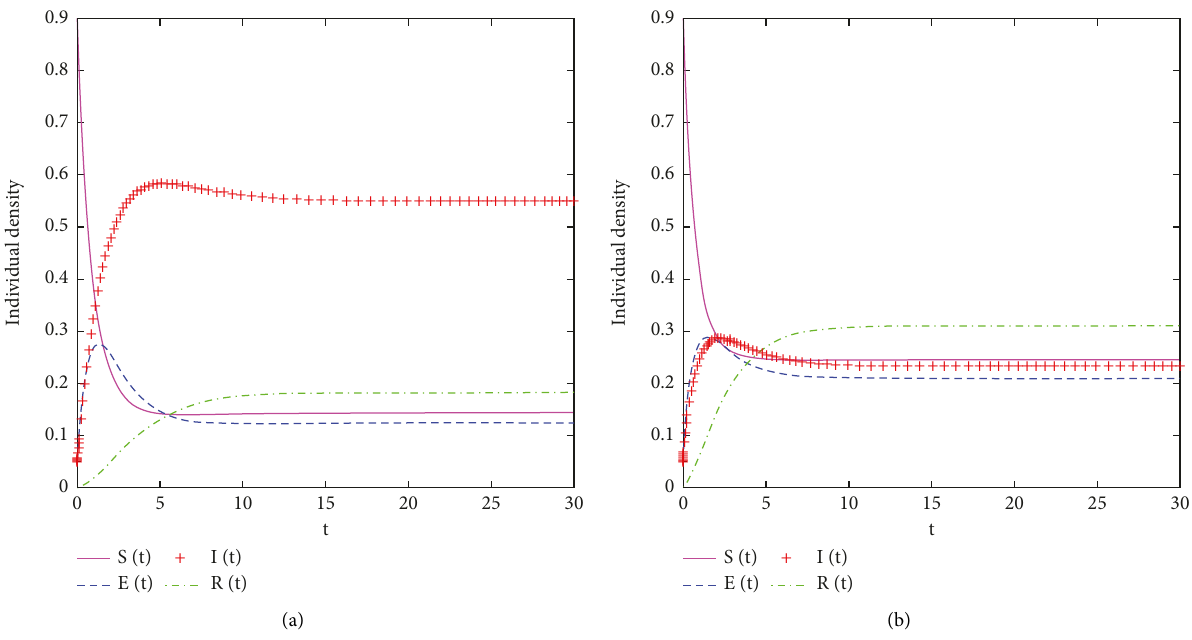
Figure 5: Simulation results of infected enterprises’ switching out rate on credit risk contagion. (a) β � 0.2. (b) β �